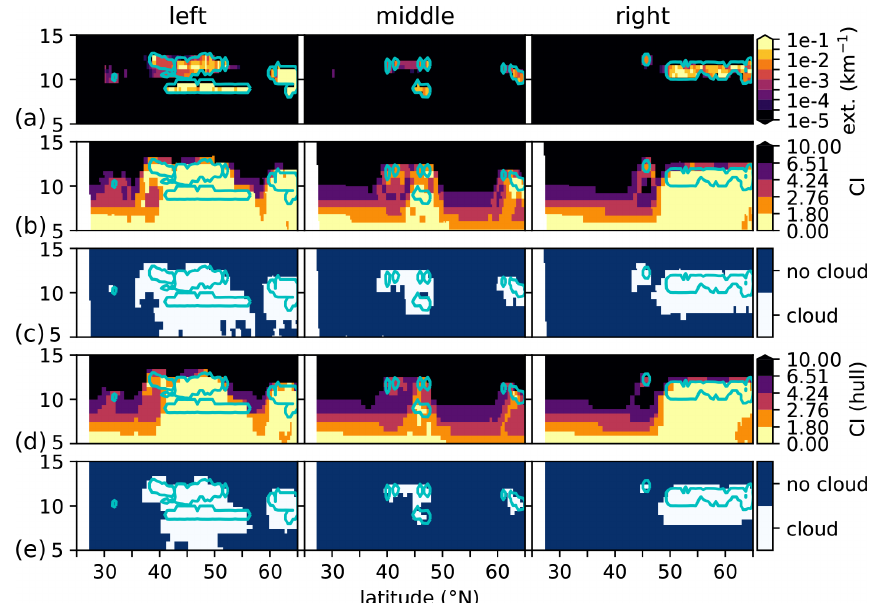
Figure 9. Cloud index and convex hull CI for three measurement tracks of a simulated IRLS instrument (left, center, and right). Panel (a) shows the extinction values used for generating the simulated measurements. Panel (b) shows the cloud index, and (c) shows the correspond- ing cloud detection. Panel (d) shows the CI as derived from the convex hull CI algorithm, whereas (e) shows the cloud detection for the convex hull CI. The contour line for a “true” extinction value of 10 − 3 km − 1 is shown as a light blue line in all panels.